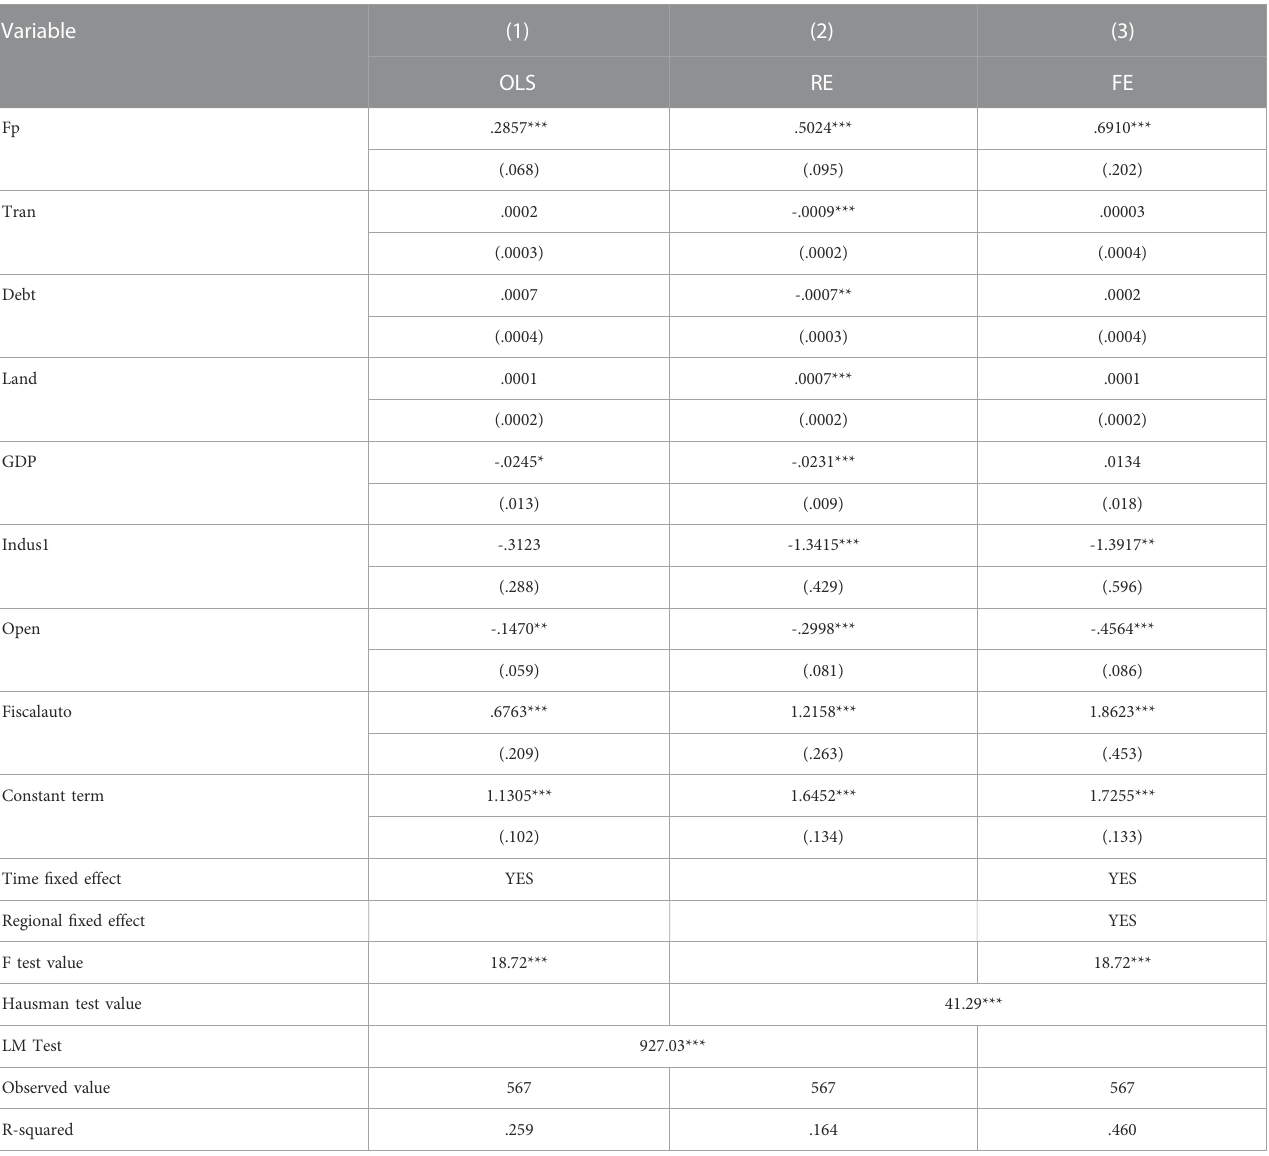
TABLE 2 Test results of the impact of fi scal pressure on tax efforts.